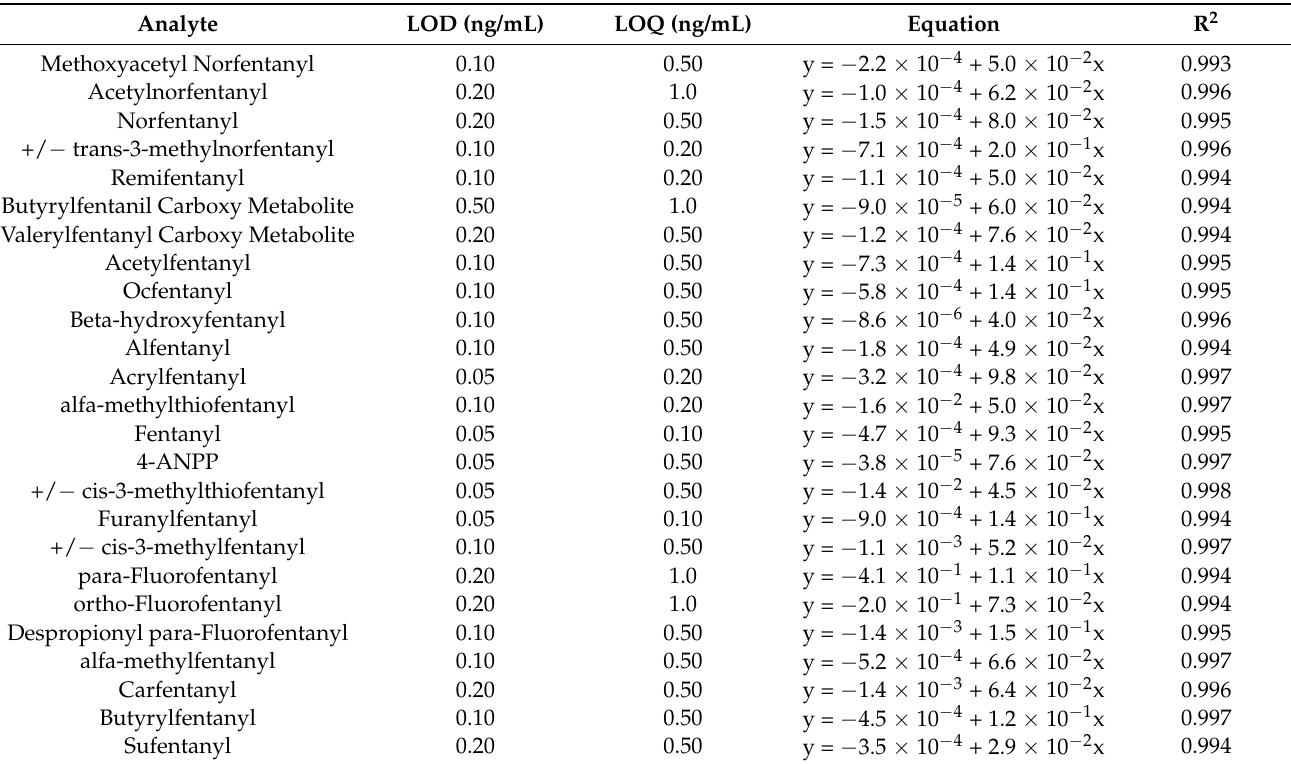
Table 1. Validation data; LODs, LOQs and